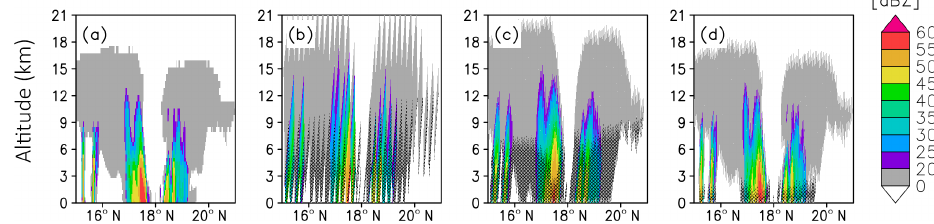
Figure 9. Precipitation reflectivity (dBZ) along the 136.4 ◦ E longitude line passing through the typhoon center in the mature stage (00:00UTC, 5 August 2015) for (a) the truth, (b) bw20bs20, (c) bw20bs05, and (d) bw05bs05. The areas where reflectivity from pre- cipitation<0dBZ are left blank, and the area in which the SCR<0 is hatched in ( b )–( d